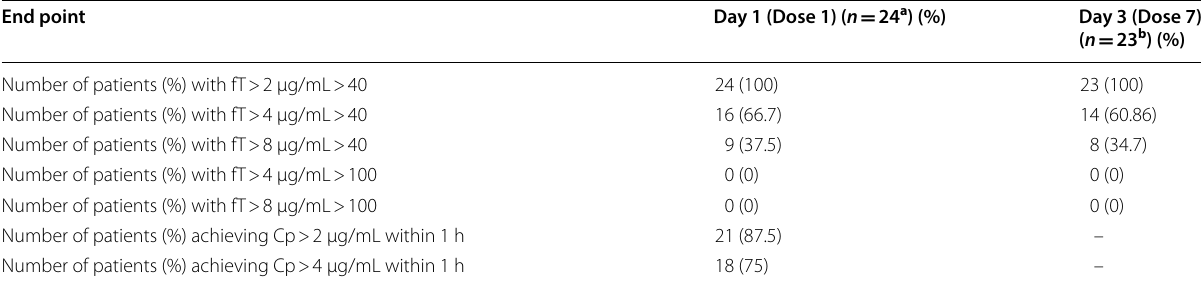
Table 2 Targets achieved with a 3-h extended infusion of meropenem 1000 mg 8 hourly